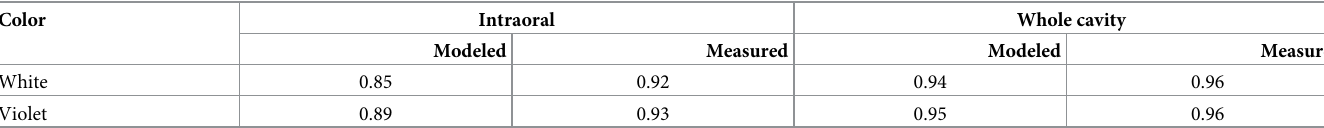
Table 2. Measured and modeled uniformity for white light and violet light for the intraoral probe and whole mouth module. The measured uniformity is adjusted by the relative illumination of each optical system. Color